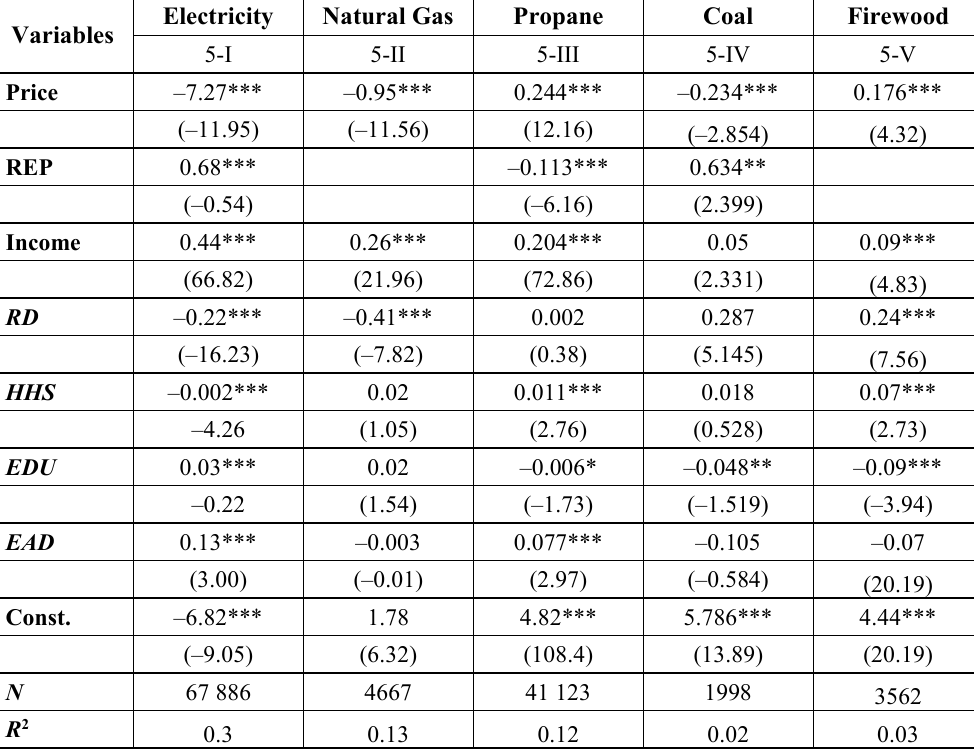
Table 8. Residential Demand Estimated